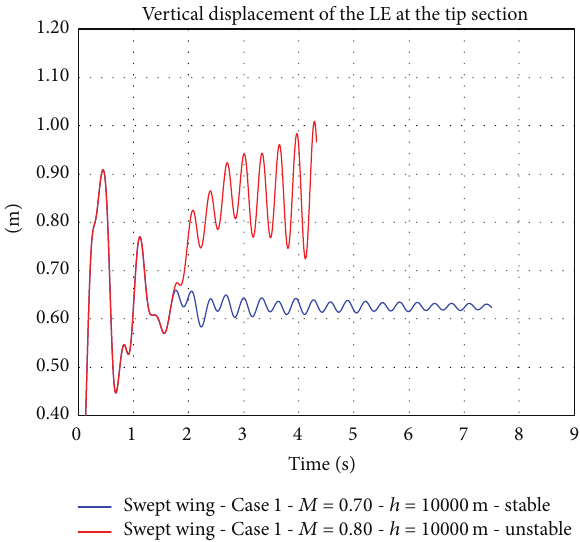
Figure 9: Results of the FSI analyses of the swept wing (Case 1 , cruise